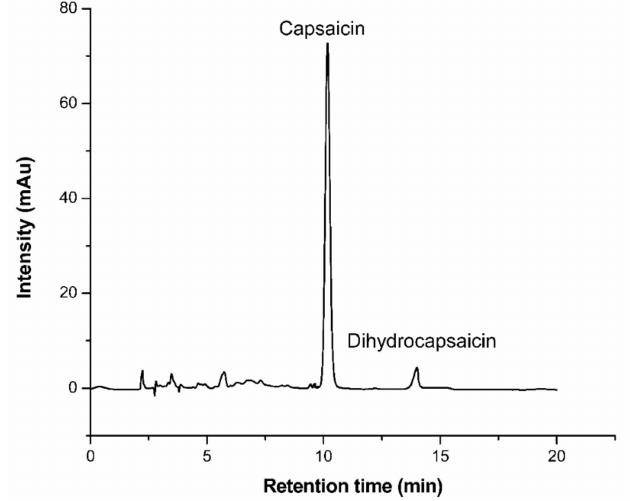
Figure 7. HPLC chromatograms of capsaicin eluent from the SKP-10-4300